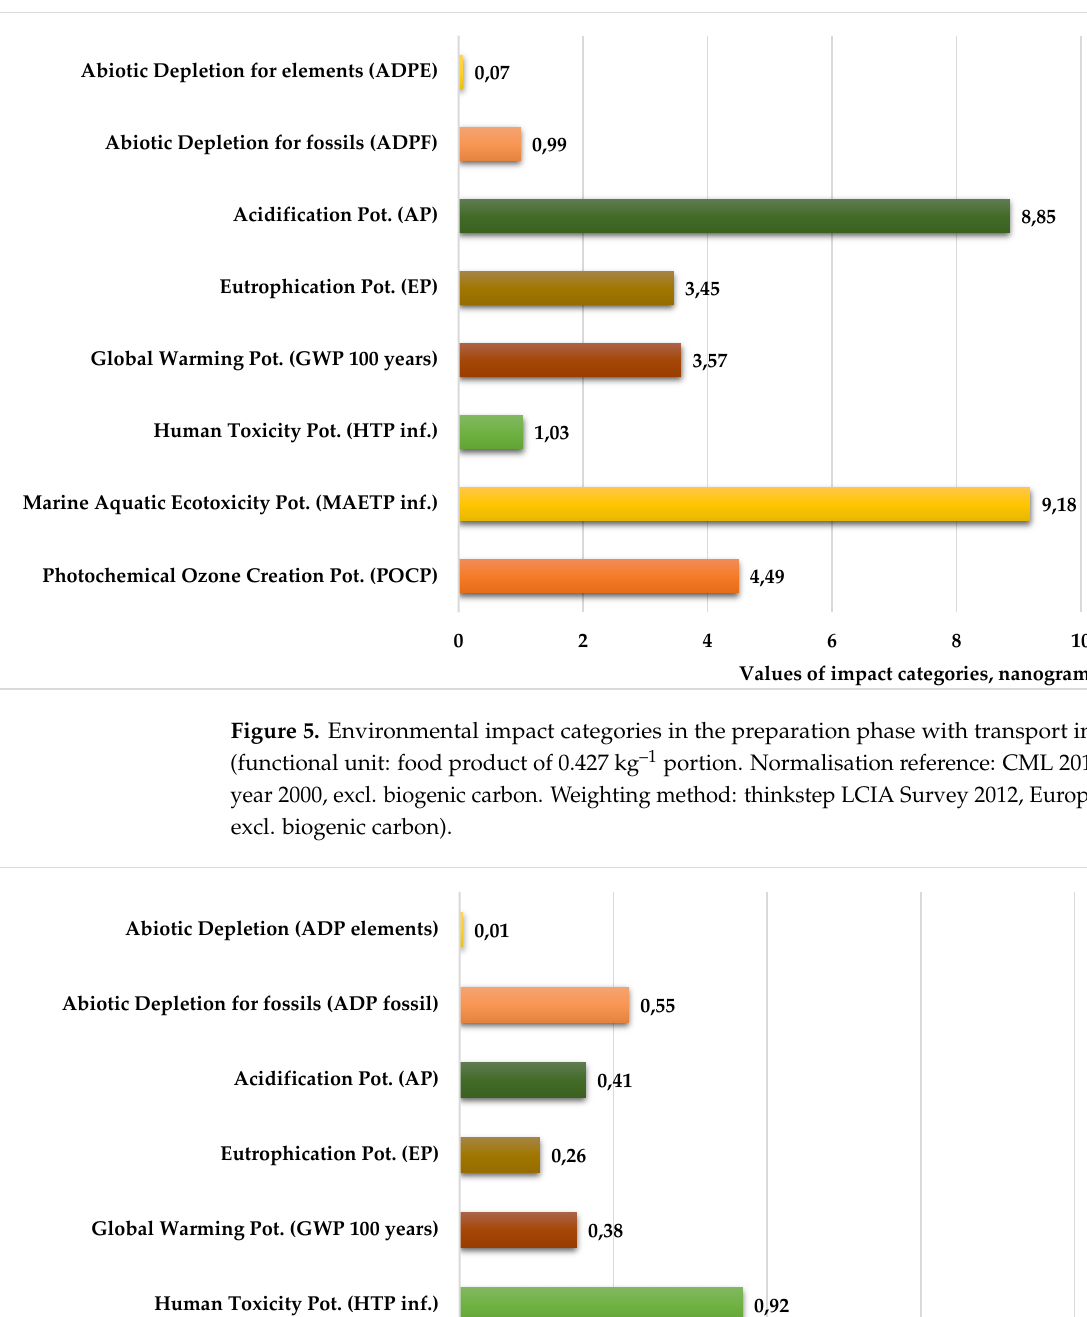
10 of 21 Figure 4. Percentage distribution of municipal solid waste in the European Union (year: 2021) (self- edited illustration). 3.2. Environmental Impact Results for the Production Stage